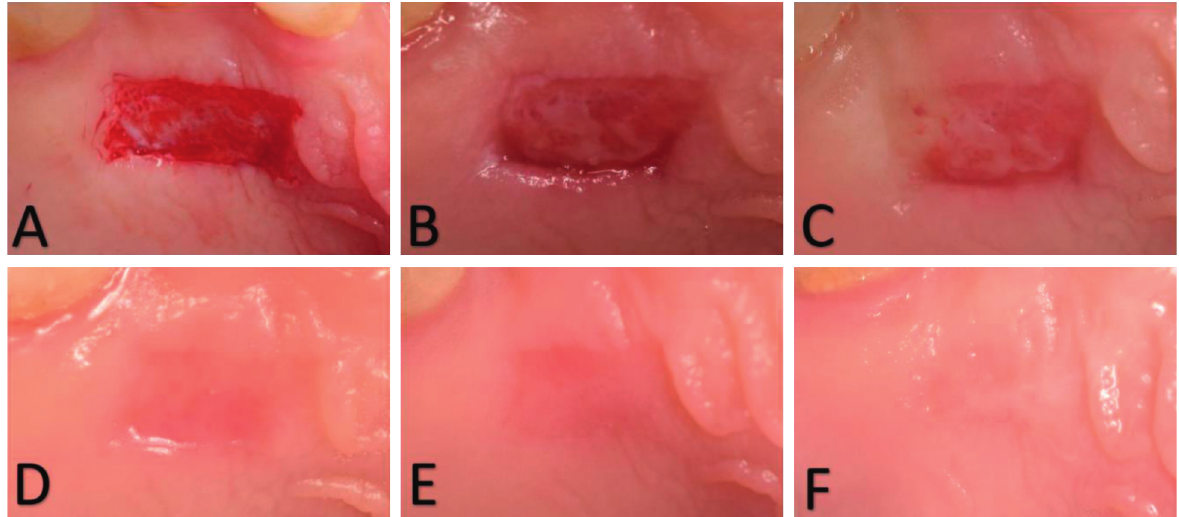
Figure 1: Clinical photographs showing palatal wound healing for the MEBO group: (a) day 0, (b) day 3, (c) day 7, (d) day 14, (e) day 21, and (f) day 42.